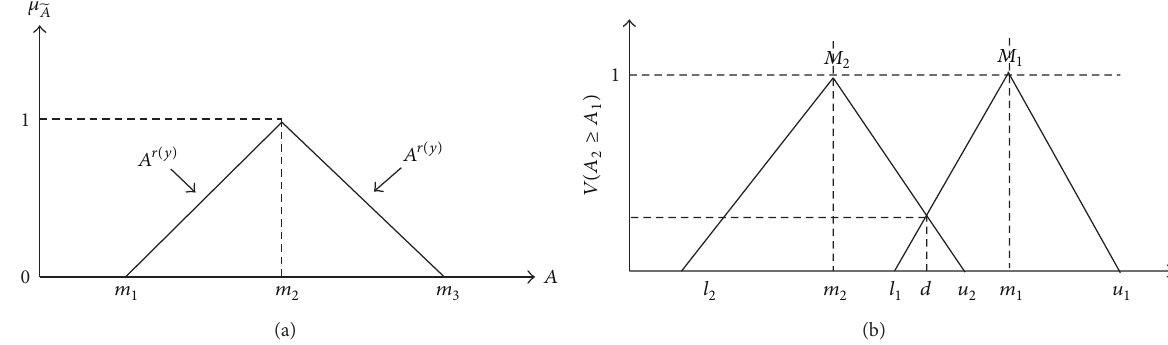
Figure 6: (a) A triangular fuzzy number, 𝑀 , and (b) the intersection between 𝑀 1 and 𝑀 2 in extent fuzzy analysis.